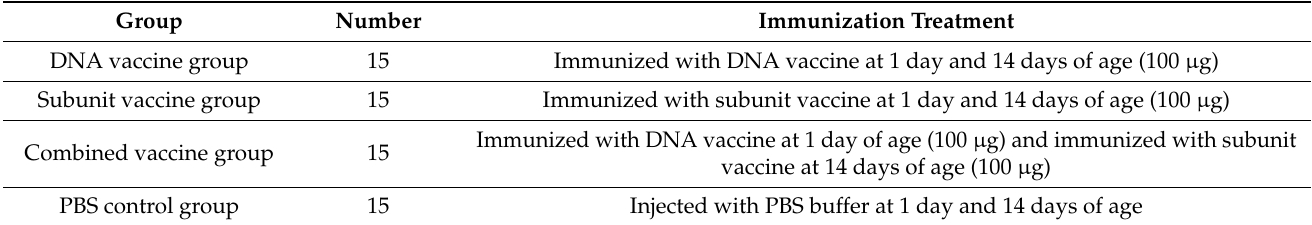
Table 2. Groups of different vaccine immunization